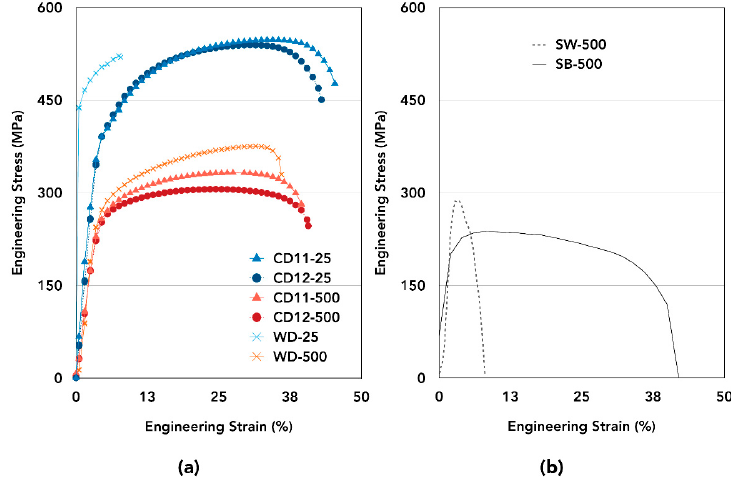
Figure 10. The tensile testing results: ( a ) flat specimens; ( b ) rod specimens.